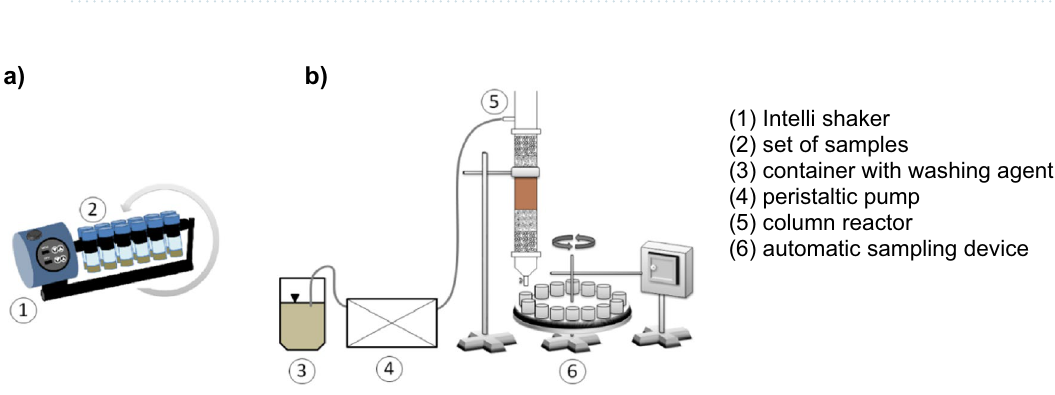
Table 1. Selected physicochemical soil properties (mean value ± standard deviation, n = 3).